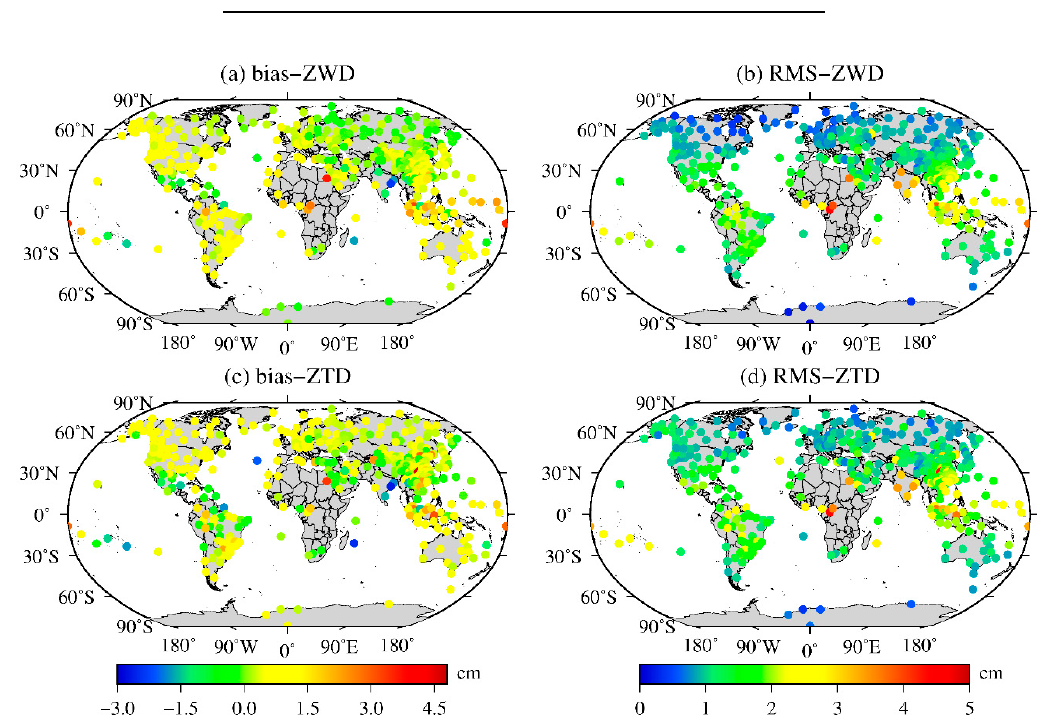
Figure 9. Global distributions of the annual average ( a , c ) bias and ( b , d ) RMS of the ZWD and ZTD values from the MERRA-2 data compared to the radiosonde data from 2015.